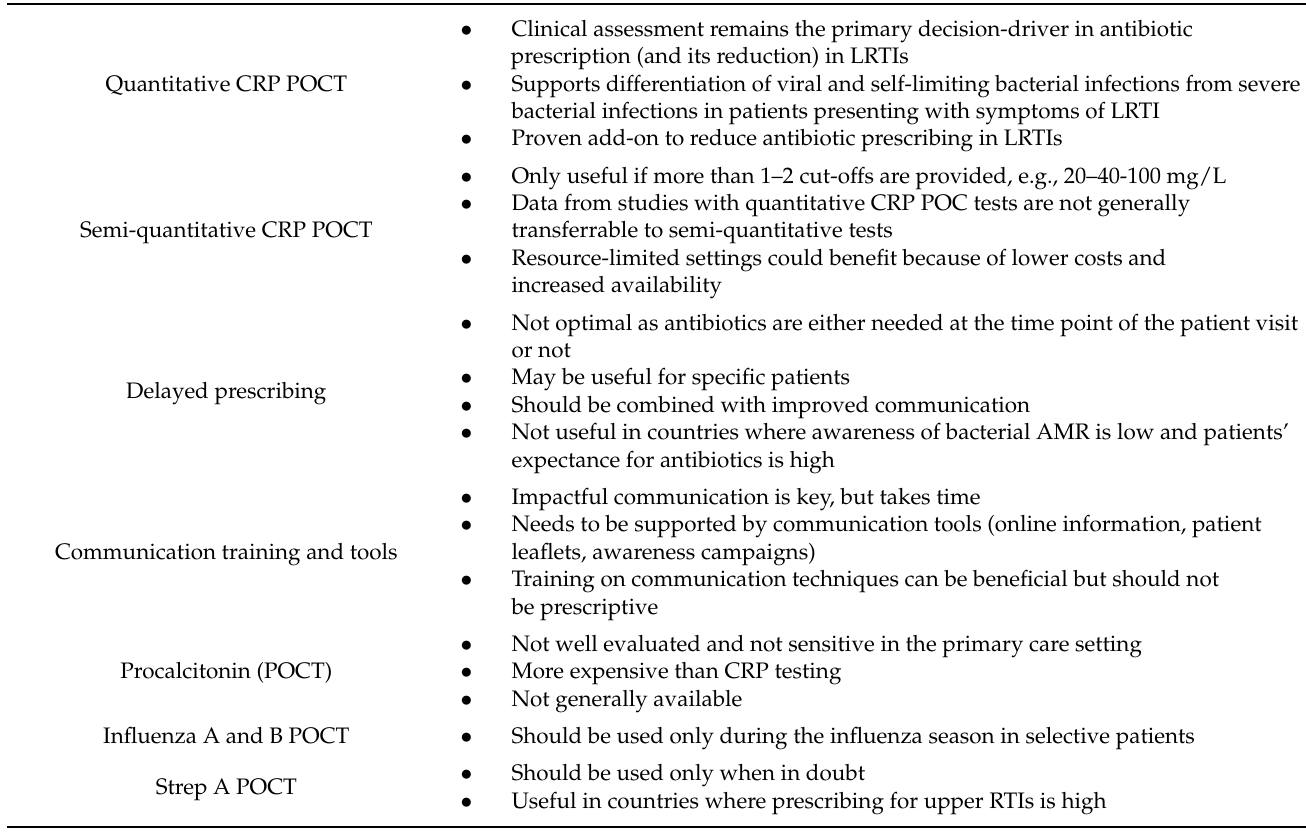
Table 3. Strategies to reduce antibiotic prescribing in